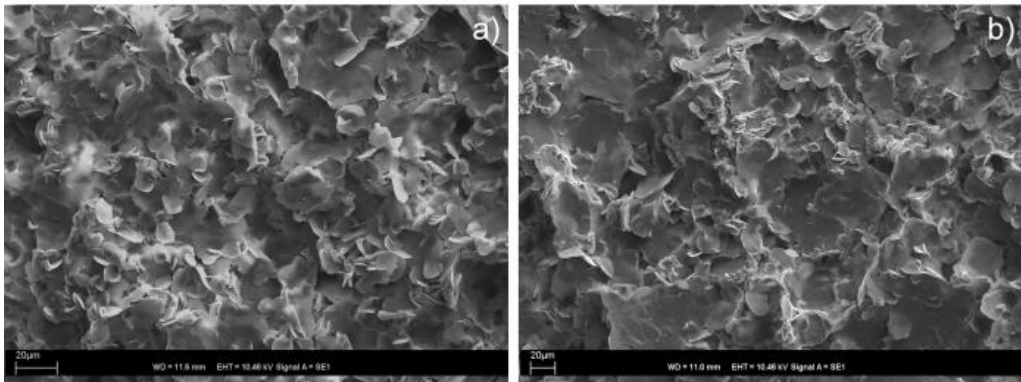
Figure 1. SEM micrographs of xerogels from propan-1-ol of ( a ) of the in situ prepared imine 3 ; and ( b ) the synthetically prepared imine 3